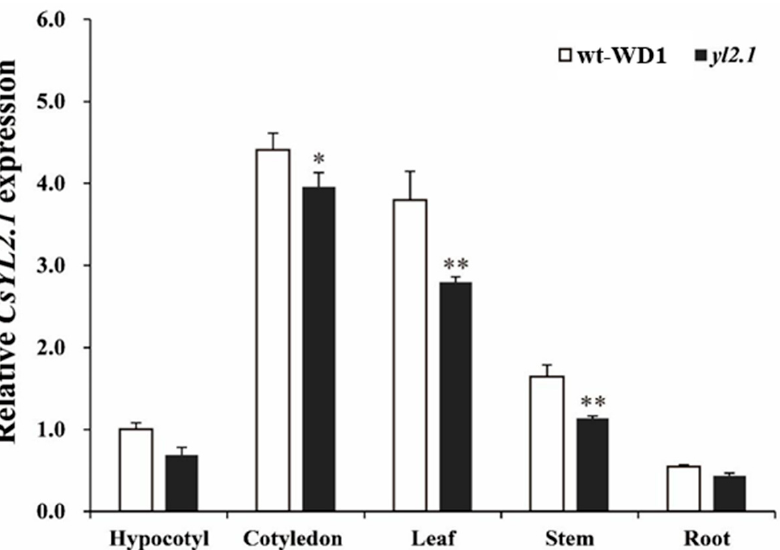
Figure 4. Relative expression of the CsYL2.1 candidate gene. Relative expression of the CsYL2.1 candidate gene in wt-WD1 and yl2.1 was measured by qRT-PCR in the hypocotyls, cotyledons, leaves, roots, and stems. For each sample, three independent biological replications were performed. Data are means ± SD ( n = 3). Transcript levels of CsYL2.1 were normalized with CsActin and expression was shown relative to the hypocotyl of wt-WD1, the values of which were set as 1. Asterisks indicate statistically significant differences compared with wt-WD1 at ** p < 0.01 and * p < 0.05 by Student’s t -test.